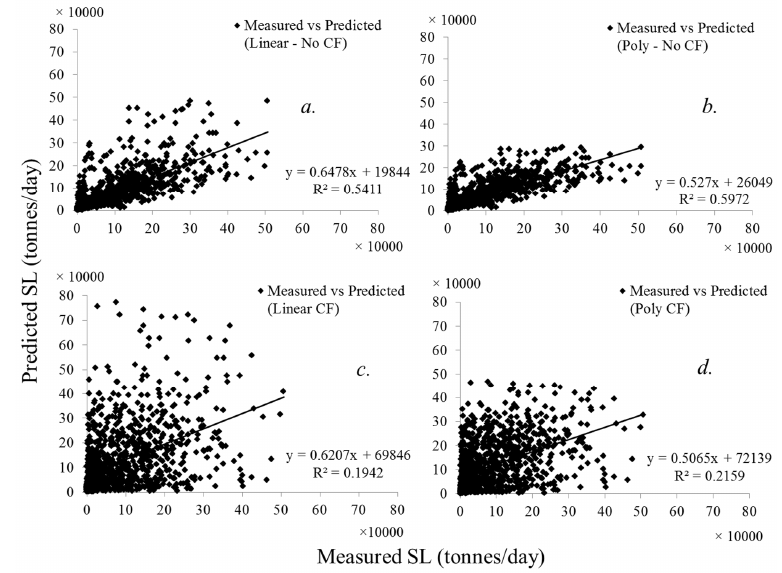
Figure 2. Scatter plots showing comparison between sand loads calculated from sand concentrations measured, processed and calibrated by USGS (Measured SL) and those predicted from single sand-rating curve (either linear or polynomial) (Predicted SL) at Tarbert Landing from 1973 to 2013. Here, linear rating curves were used for predicting SLs in ( a ) and ( c )while polynomial rating curves were used for predicting SLs in ( b ) and ( d ). In addition, Duan correction factors were applied in predicted SLs of curves ( c ) and ( d ) (denoted by “CF” in the figure) while the SLs in curves ( a ) and ( b ) were predicted without correction factors (denoted by “No CF” in the figure).